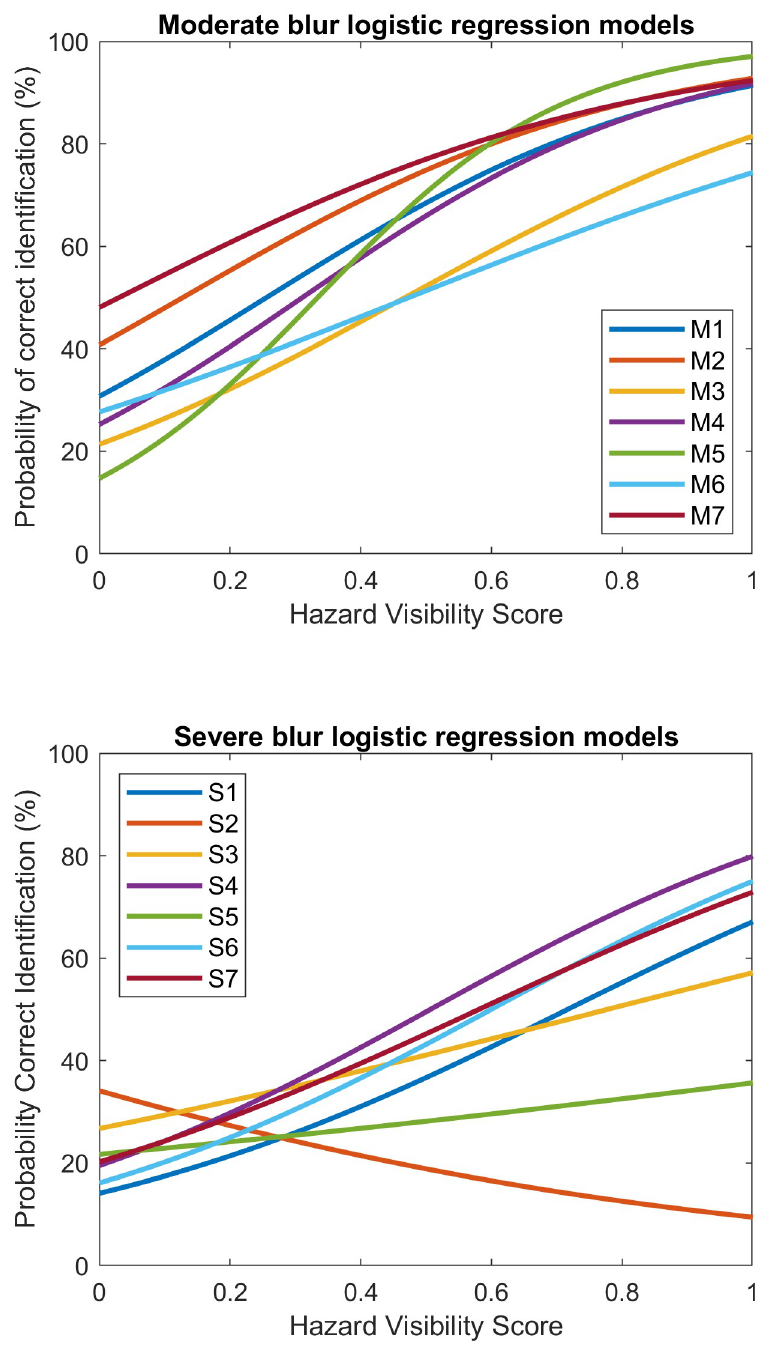
Fig 6. Logistic regression models of 14 subjects with artificial acuity reduction by blur. Top: Moderate Blur Group. Bottom: Severe Blur Group.